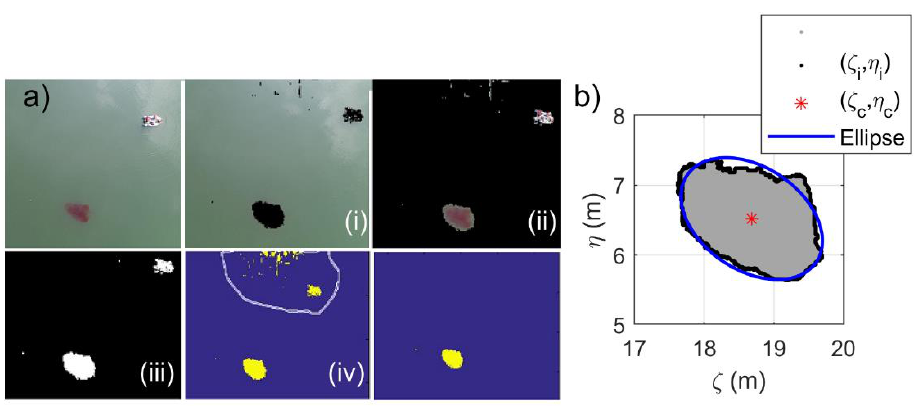
Figure 3. ( a ) Image processing steps (i) selection of the RGB intensity, (ii) inverted mask, (iii) bi- nary image, and (iv) selection of the dye patch. ( b ) Optimal ellipse for the boundary dataset ( ζ i , η i ) .